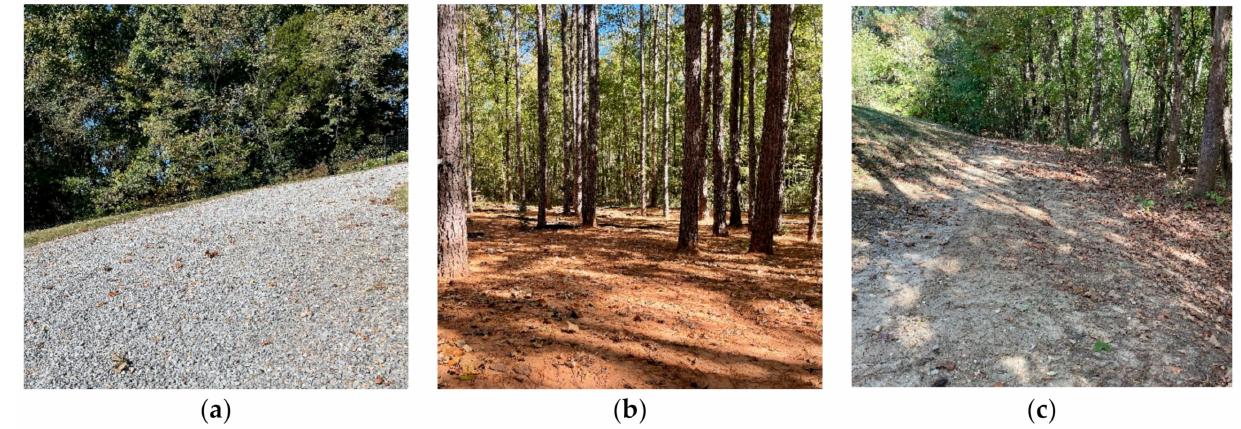
Figure 1. Examples of some off-road environments with unstructured roadways; The figure presents ( a ) rocky, ( b ) muddy, and ( c ) sandy road environments. Images are collected from the autonomous testing ground of the Center for Advanced Vehicular Systems (CAVS) at Mississippi State Univer- sity